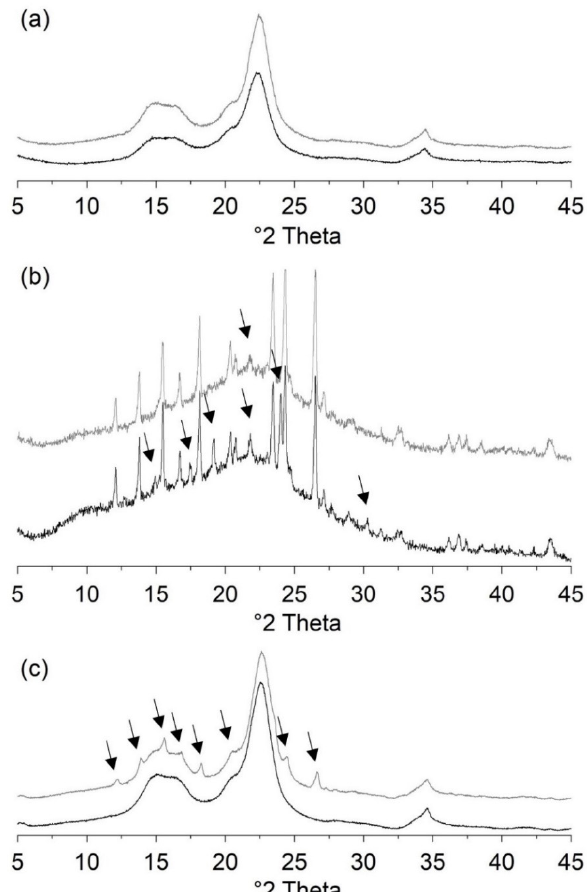
Figure 5. XRD studies of ASD tablets: ( a ) tablets of ASD VA30 with MCC 200 compressed at 20 kN and a dwell time of 1 s. Black curve: amorphous halo directly after preparation. Gray curve: amorphous halo after six months of storage at 40 °C/75% RH; ( b ) tablets of pure ASD VA40, compressed at 5 kN and a dwell time of 1 s. Black curve: diffraction peaks after six months of storage at 23 °C/75% RH. Gray curve: diffraction peaks after six months of storage at 40 °C/75% RH. The arrows indicate the diffraction peaks of PCM polymorphic form II; ( c ) tablets of ASD VA50 with MCC 200, compressed at 5 kN and a dwell time of 10 s. Black curve: amorphous halo directly after preparation. Gray curve: diffraction peaks of polymorphic form I after one week of storage at 23 °C/75% RH. The arrows indicate the diffraction peaks of PCM polymorphic form I.